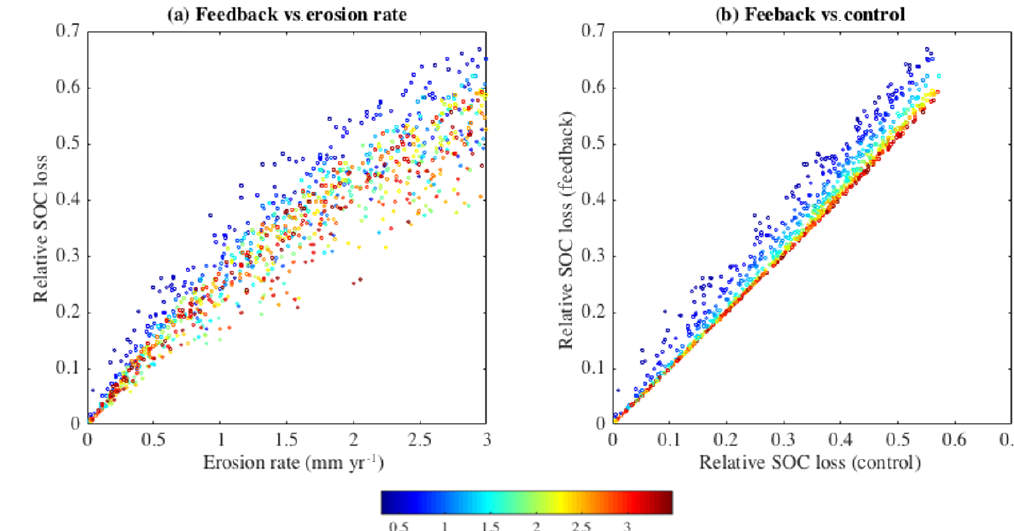
Figure 5. (a) Relative SOC loss after 200 years for the dataset including the effect of erosion on productivity (FB) as a function of erosion rate (mmyr − 1 ). (b) Relative SOC loss for FB against the relative SOC loss of CTL, for all the erosion rates. The colour scale represents the exponent B value, where B< 0 . 9 represents a concave relationship and B> 1 . 1 represents a convex, threshold relationship. When 0 . 9 <B< 1 . 1, productivity decreases linearly with soil